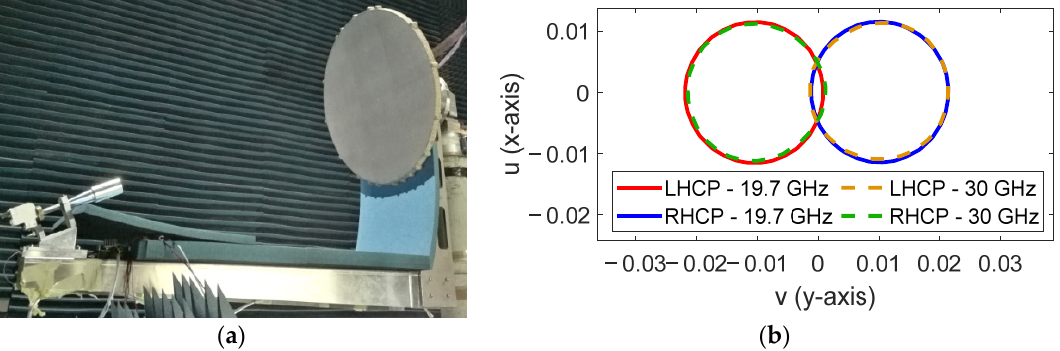
Figure 16. Dual band parabolic reflectarray prototype to generate two spaced beams per feed [26]. ( a ) Picture of the prototype, ( b ) measured 40.6 dBi pattern contours of the two beams generated at 19.7 and 30 GHz by the same feed.